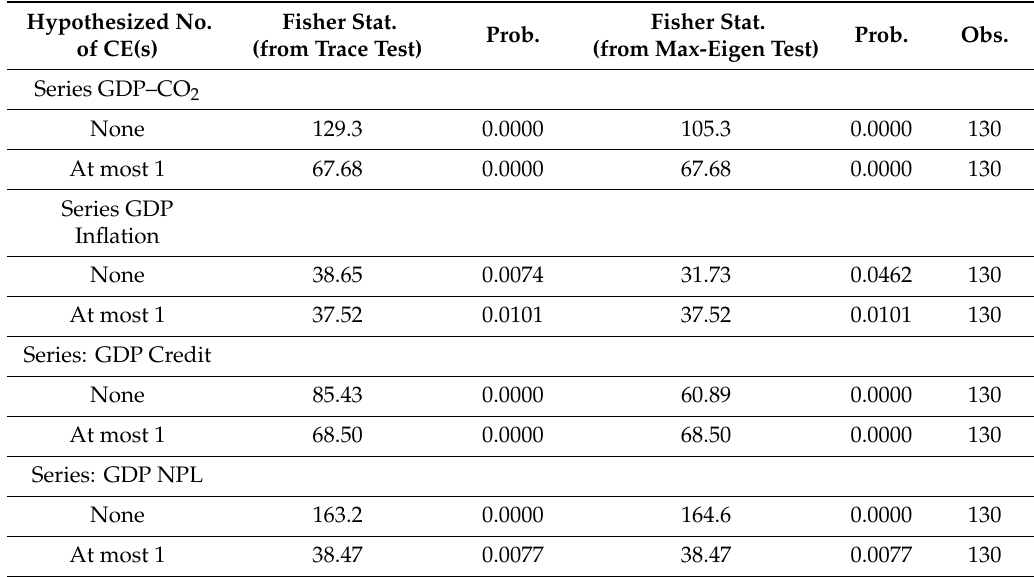
Table 8. Johansen Fisher panel cointegration